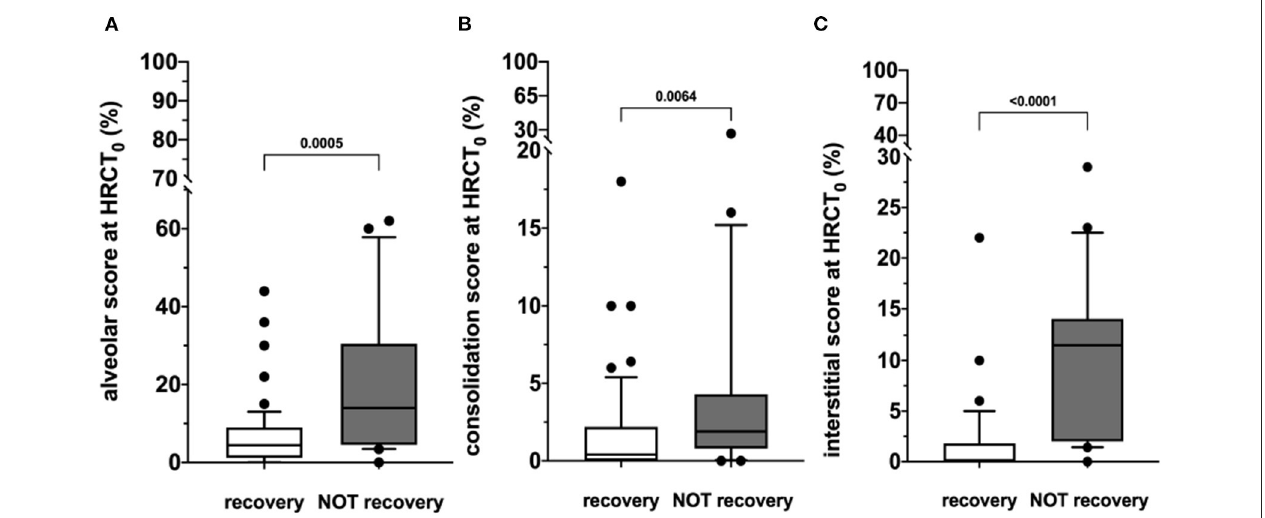
FIGURE 2 | HRCT scores during hospitalization (HRCT0) of the two subgroups categorized according to the presence of radiological recovery [recovery (REC) or NOT-recovery (NOT-REC)] at follow-up period. Horizontal bars represent median values; bottom and top of each box plot 25th and 75th; brackets show 10th and 90th percentiles; and circles represent outliers. White boxes indicate values for recovery group and gray boxes not recovery group. (A) ALV [14.0 (0.0–62.0) vs. 4.4 (0.0–44.0); p = 0.0005]; (B) CONS [1.9 (0.0–26.0 vs. 0.4 (0.0–18.0); p = 0.0064]; (C) INT [11.5 (0.0–29.0) vs. 0.0 (0.0–22.0); p < 0.0001].